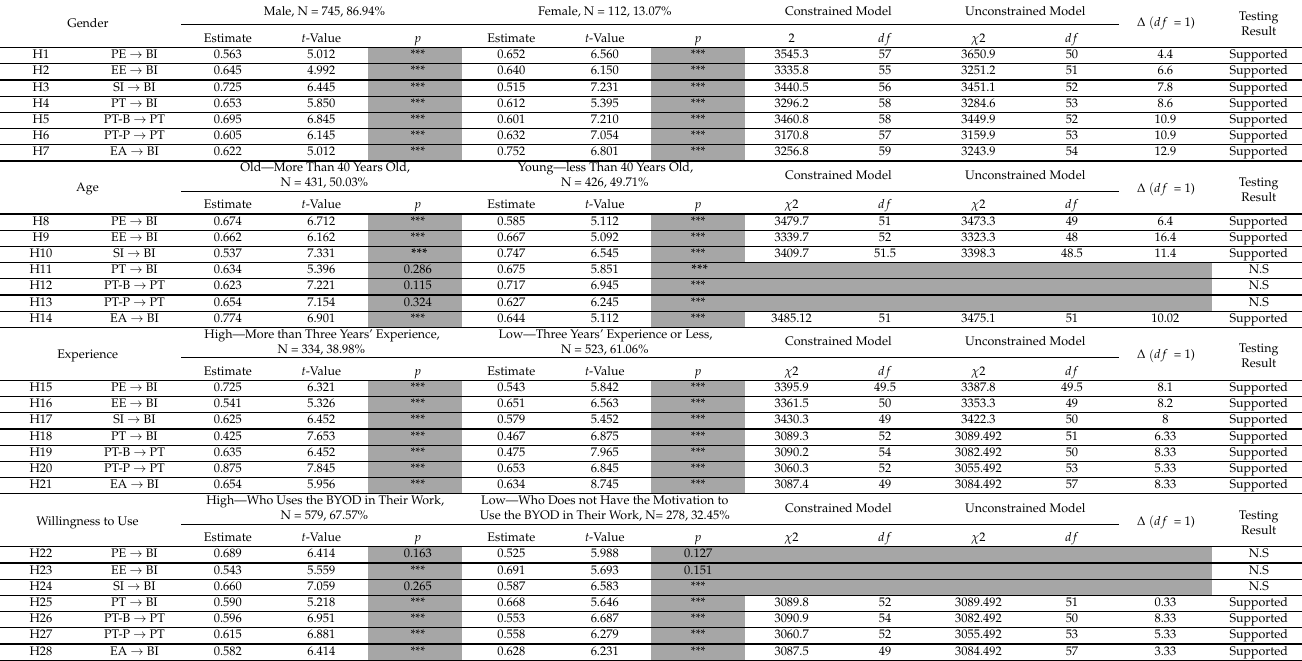
Table 6. Summary of path coefficients, t -values, and p -values of gender and experience